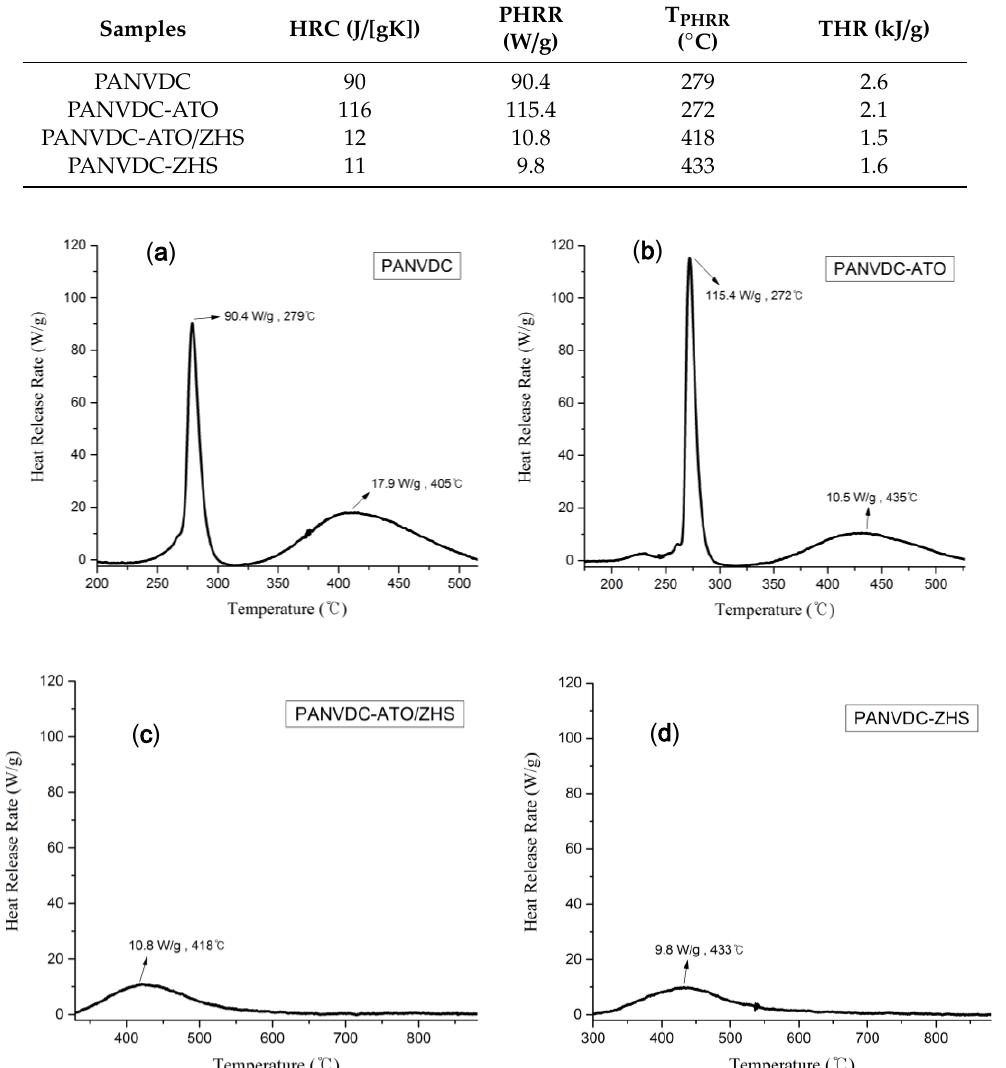
Table 6. Microscale combustion calorimetry (MCC) data of the PANVDC fibers with the flame retardants. Table6. Microscalecombustioncalorimetry(MCC)dataofthePANVDCfiberswiththeflameretardants.